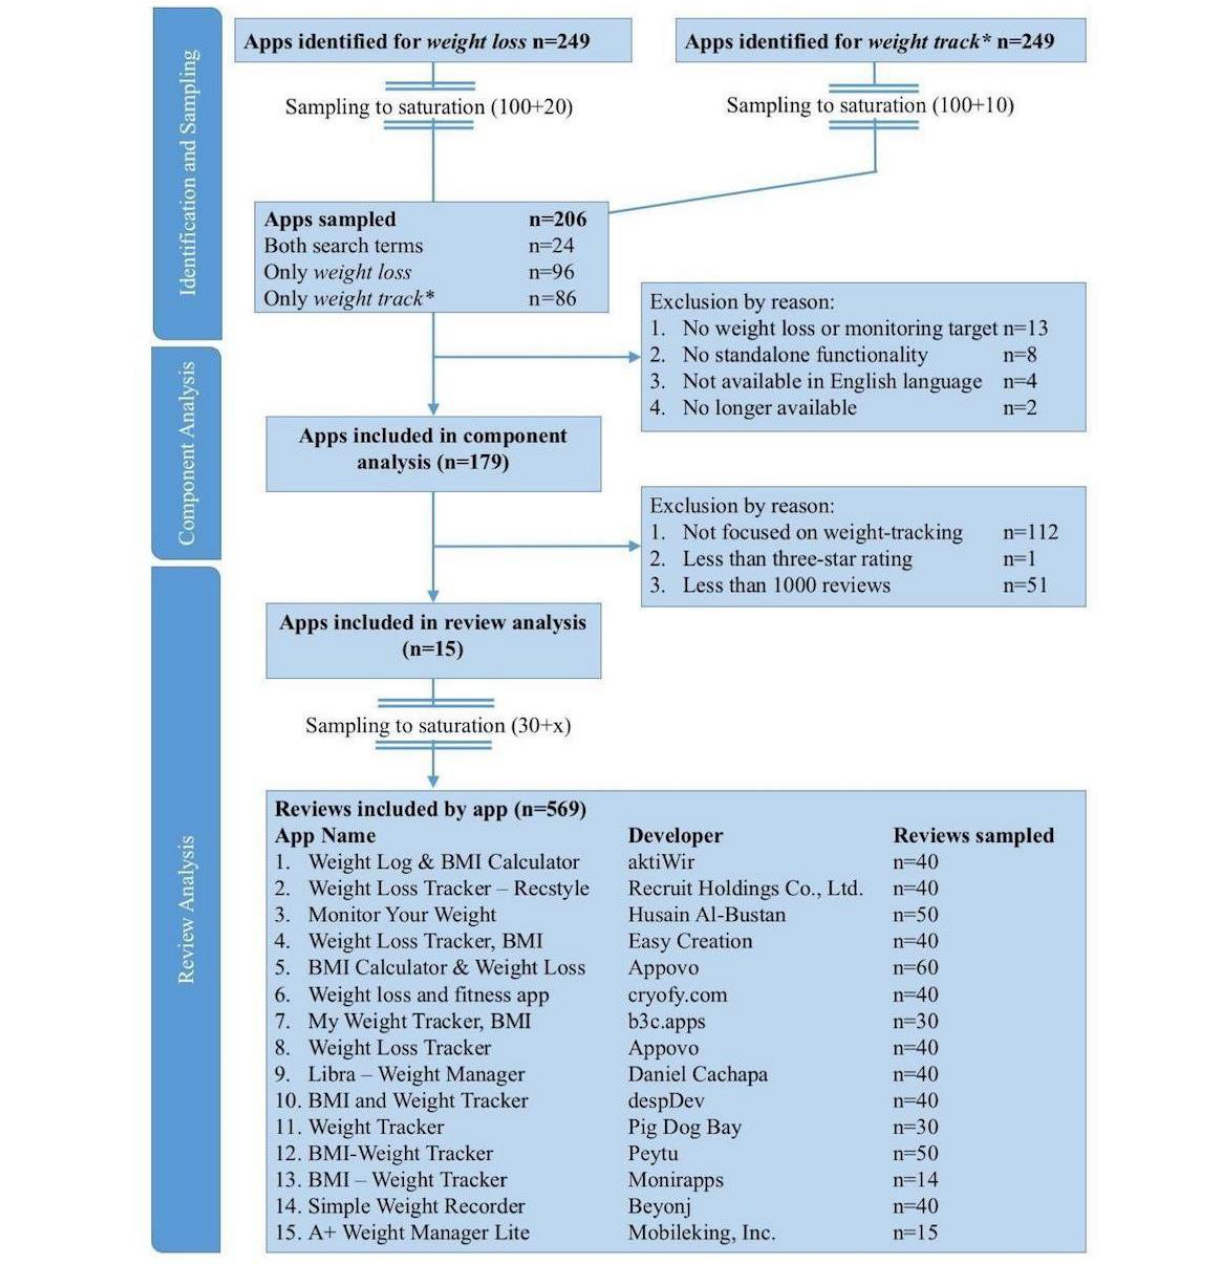
Figure 1. Screening and sampling procedure for this